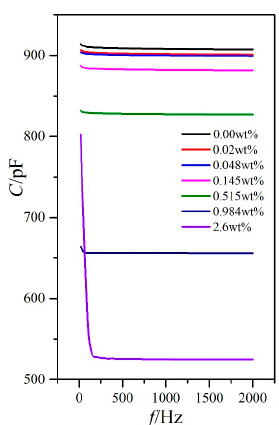
Figure 6. PAN cell capacitance versus frequency with different doped γ -Fe 2 O 3 nanoparticle concentrations under the external voltage of 1 V and temperature of 25 °C.